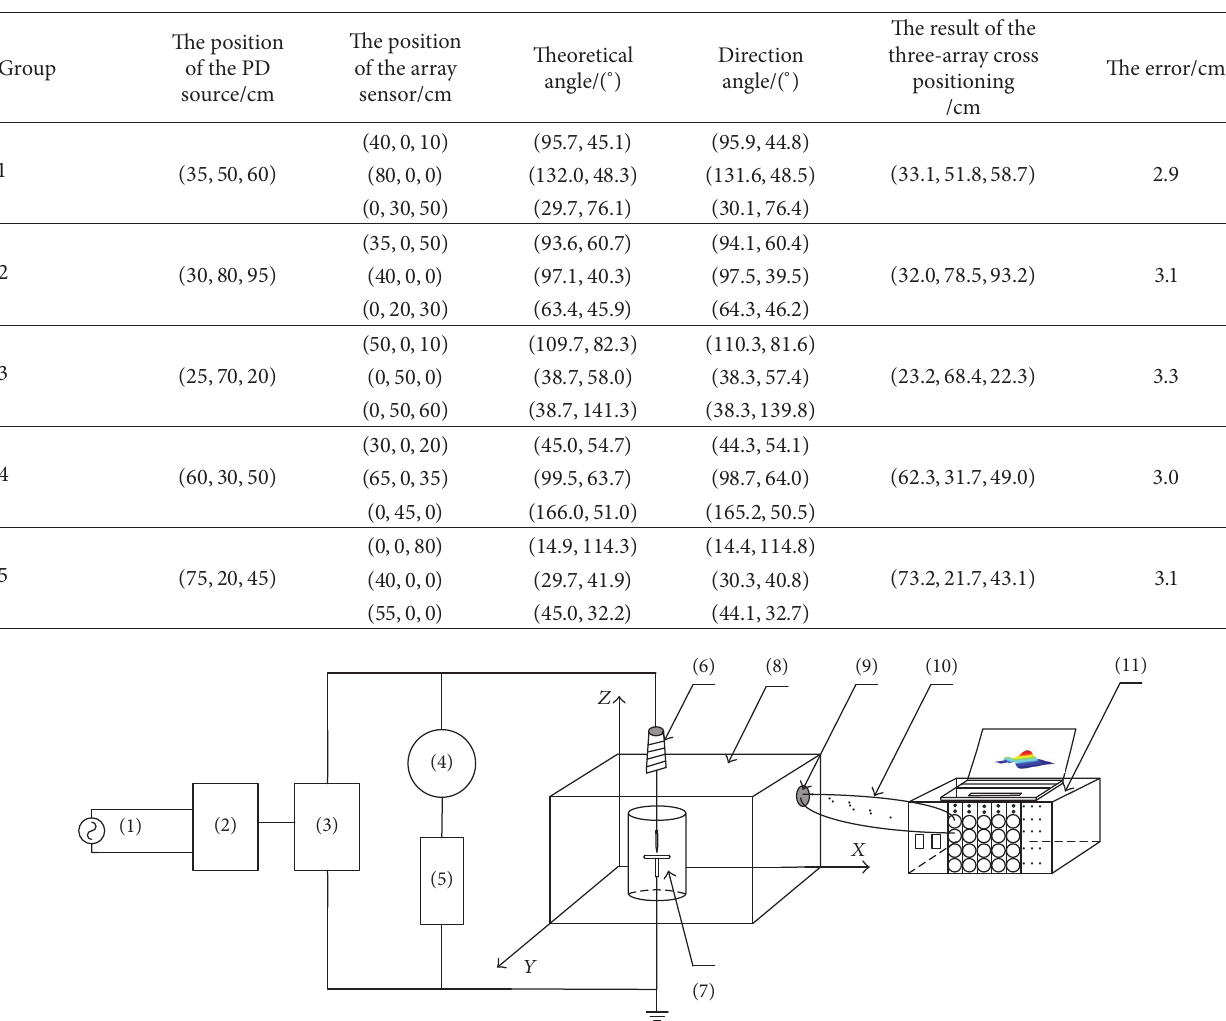
Figure 10: The structure of the PD positioning experimental system. (1) AC power regulator; (2) voltage regulator; (3) test transformer; (4) coupling capacitor; (5) impedance measurement; (6) inlet bushing; (7) PD model; (8) oil tank; (9) Partial Discharge Ultrasonic array sensor; (10) transmission lines; (11) data acquisition unit.